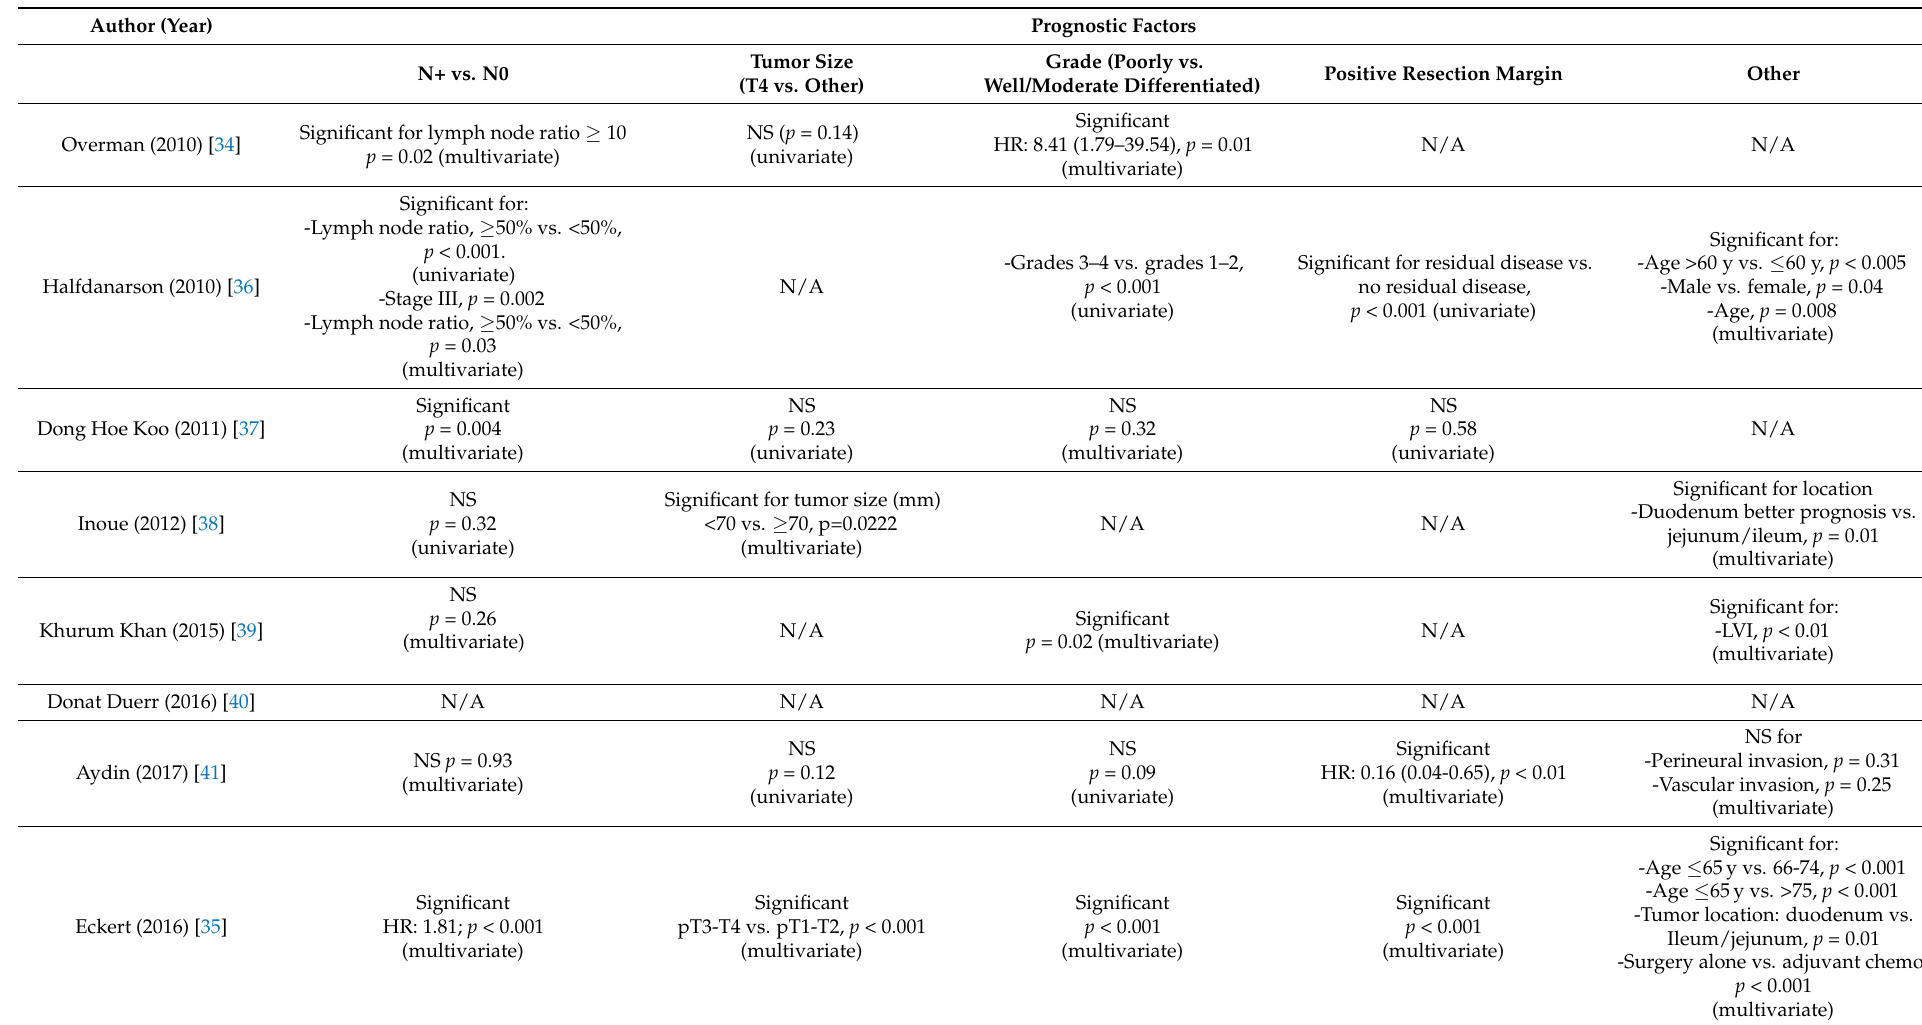
Table 3. Prognostic factors for overall